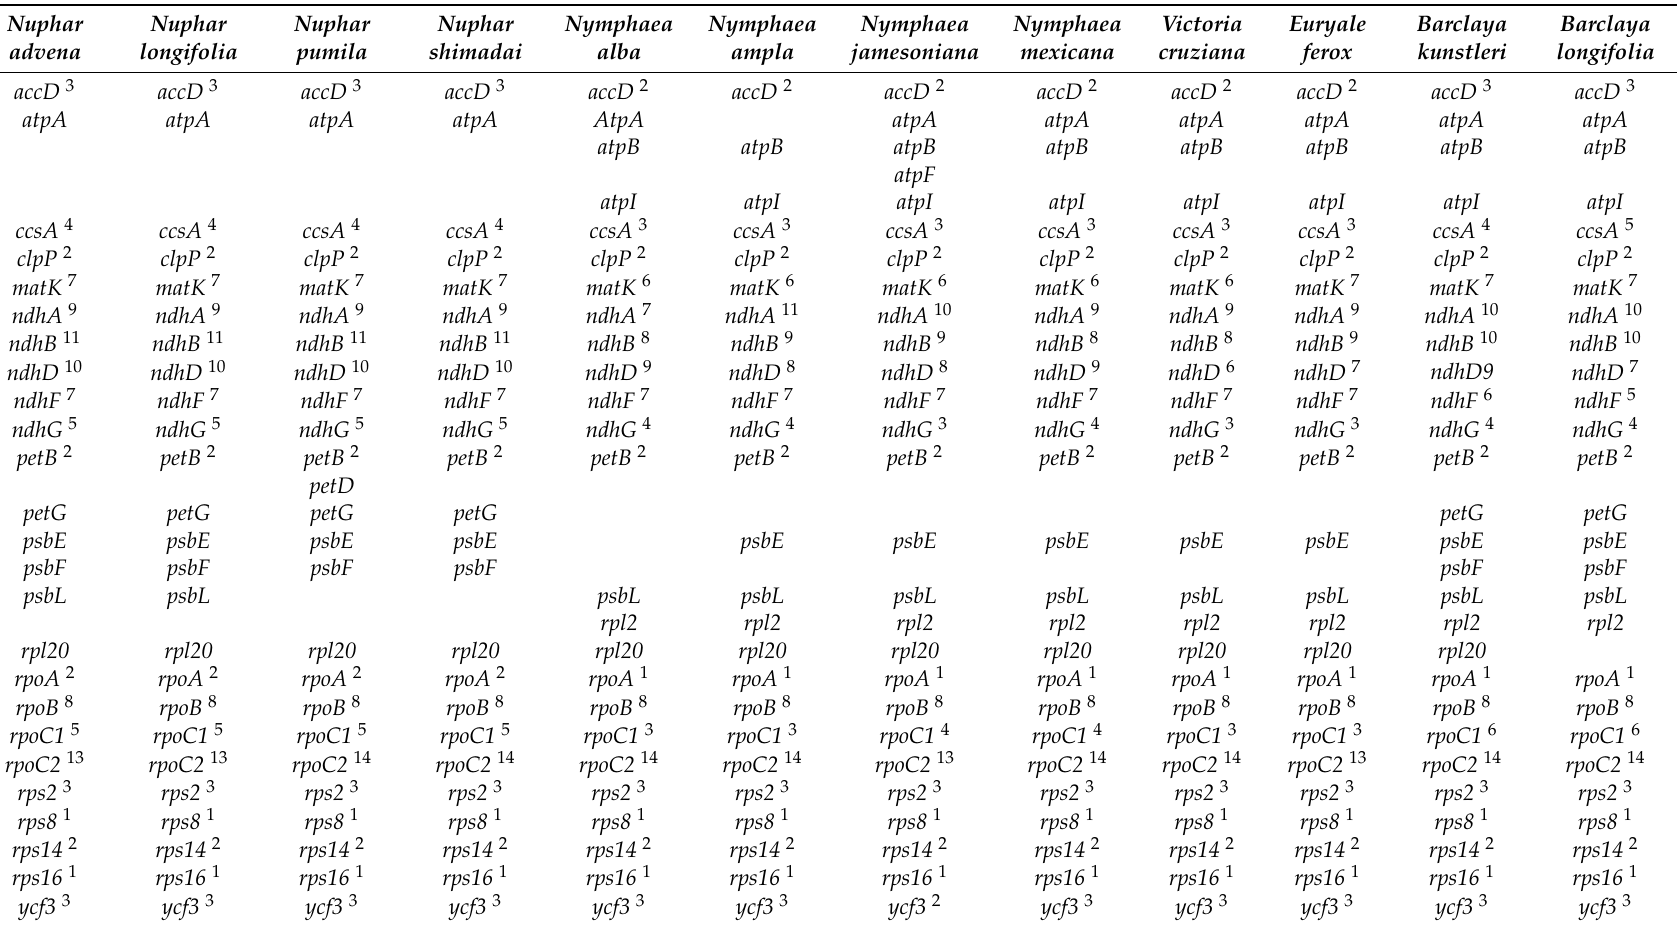
Table 3. List of protein-coding genes affected by RNA editing in each of the 12 chloroplast genomes of